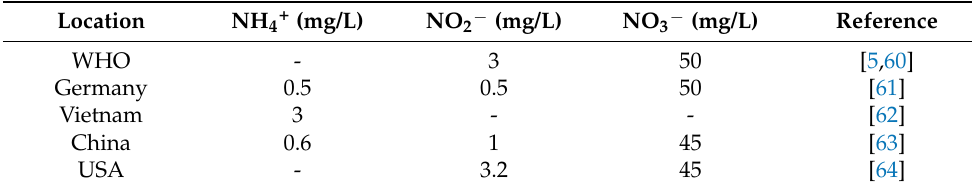
Table 6. Local drinking water threshold values for nitrogen